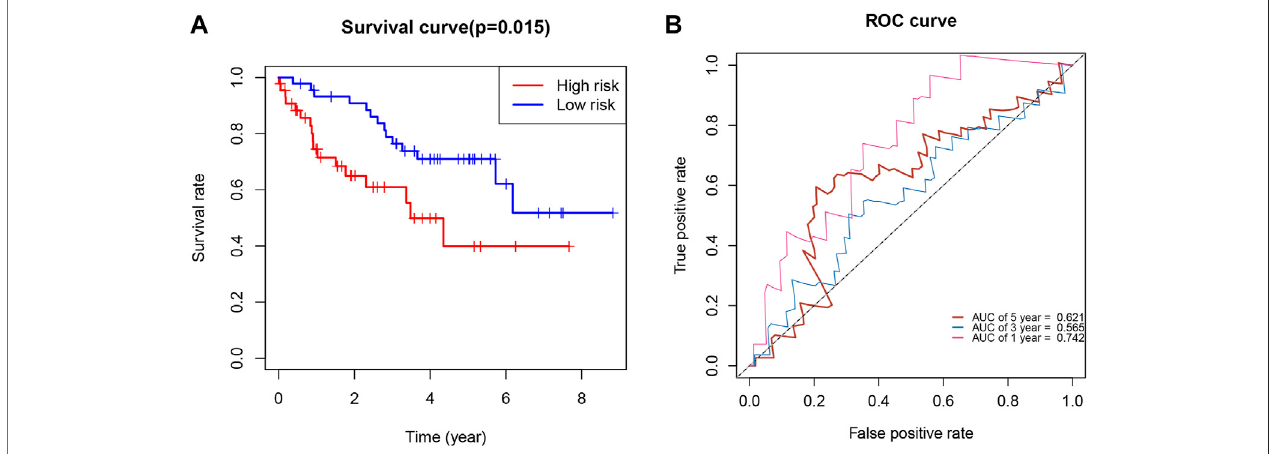
FIGURE8| (A) Survivalanalysisdemonstrated KIRCpatientsin high-risk grouphad shorter overall survivalthan those inlow-riskgourp. (B) ROCcurves for1-, 3-, and 5-year survival prediction.